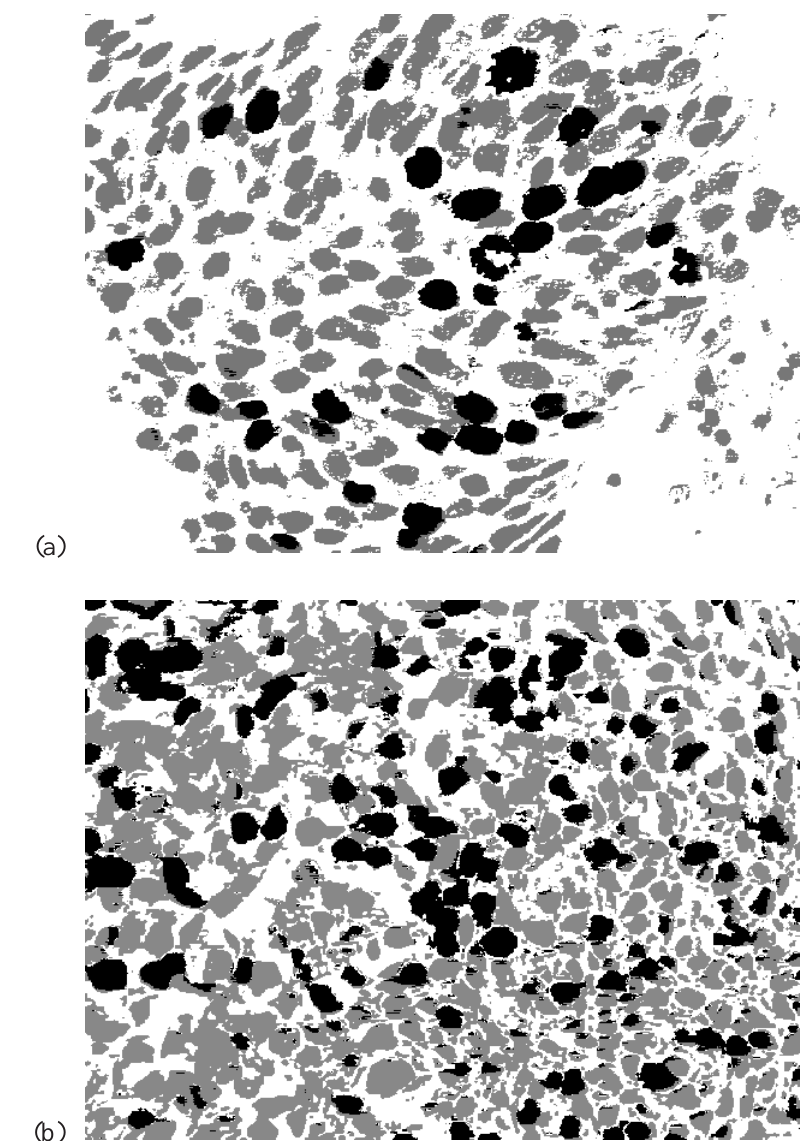
Fig. 6. Result when the described method is applied to the images in Fig. 1. Black is positive cell nuclei and grey is negative cell